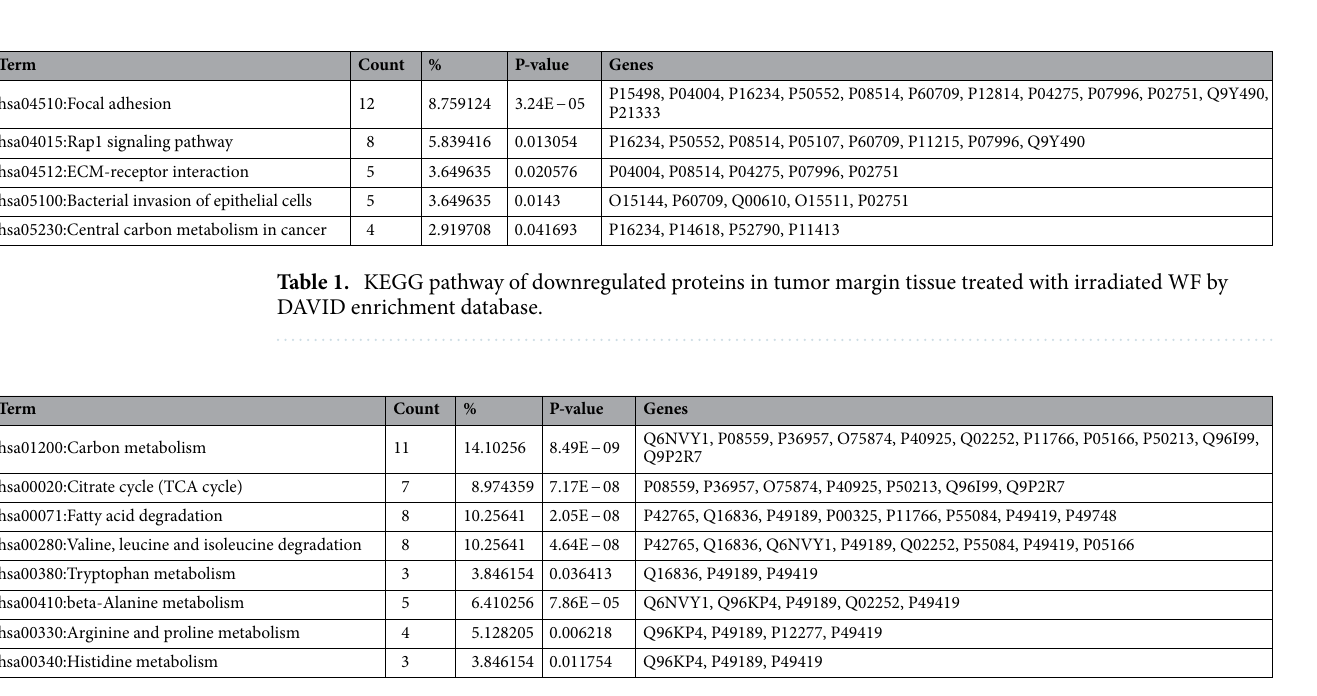
Table 2. KEGG pathway of upregulated proteins in tumor margin tissue treated with irradiated WF by DAVID enrichment